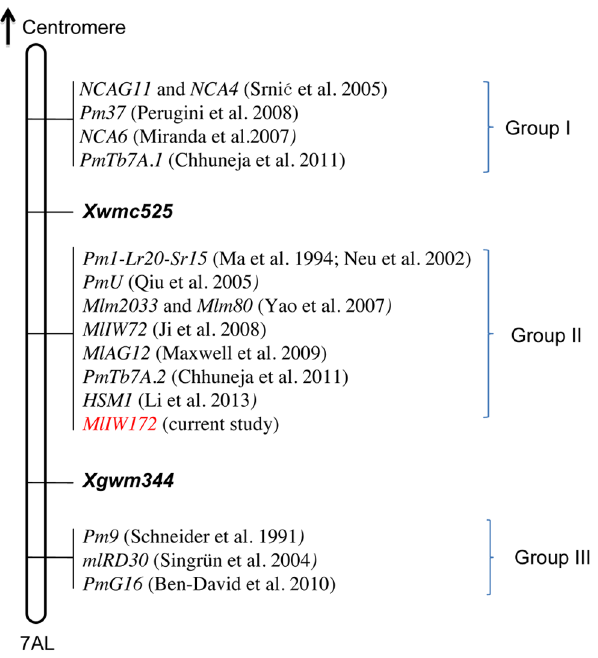
Figure 4. Integrative views of the MlIW172 gene loci with other previously published Pm genes on chromosome arm 7AL. The loci can be classified into three groups (Group I; Group II; Group III) based on their order and genetic distance to markers Xwmc525 and Xgwm344 .